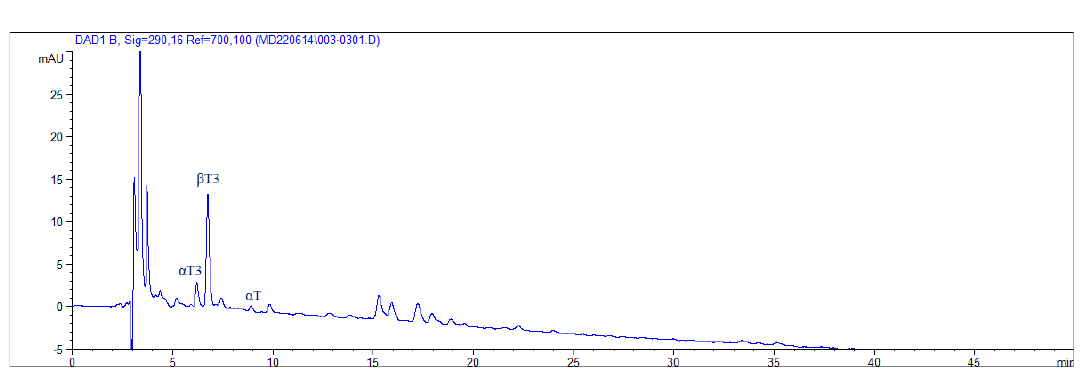
Figure A4. Representative chromatogram of tocochromanols identified on the basis of RT and absorption spectra in the extracts of Svevo, Svevo HA and Faridur. α T3, β T3, α T: α -Tocotrienol, β -Tocotrienol and α -Tocopherol, respectively.